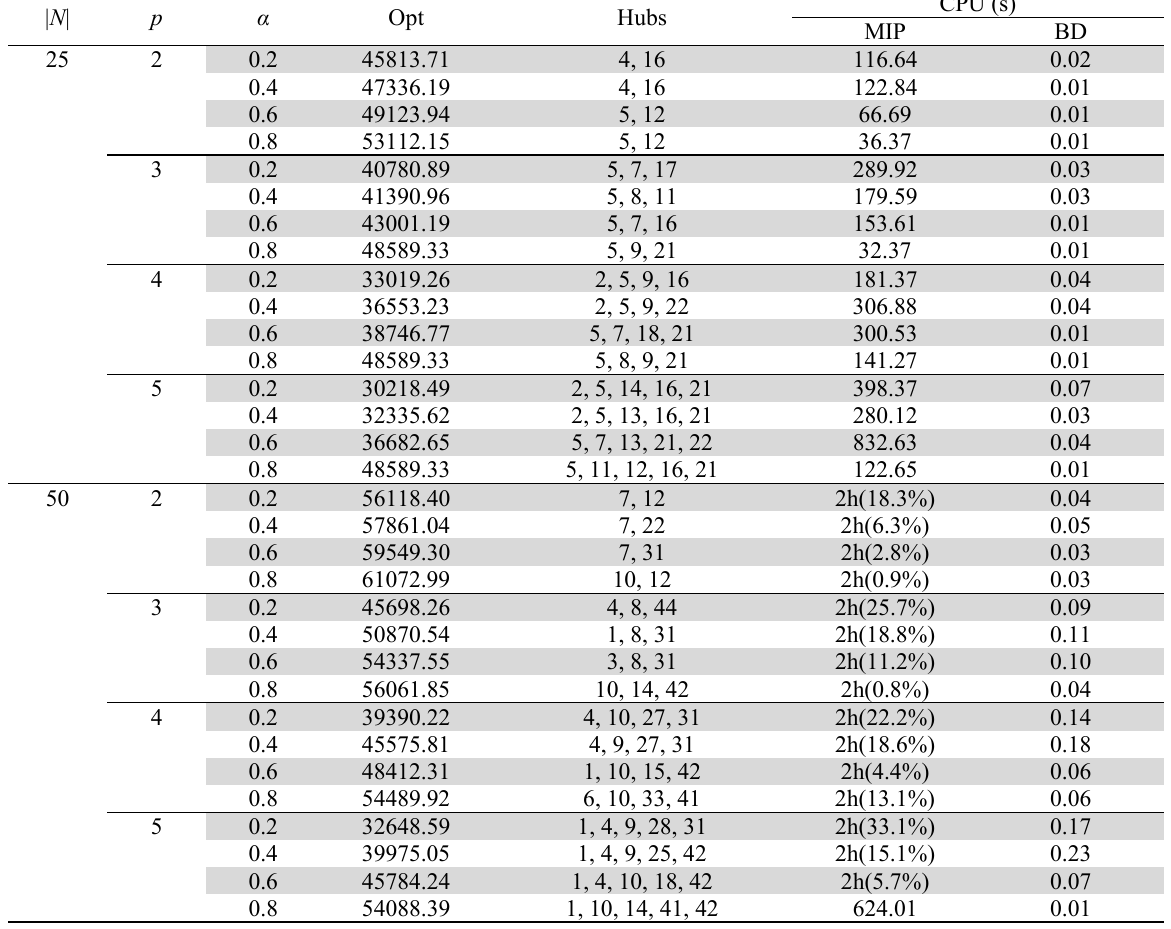
Results for solving the problem for the AP data set (small instances) | N